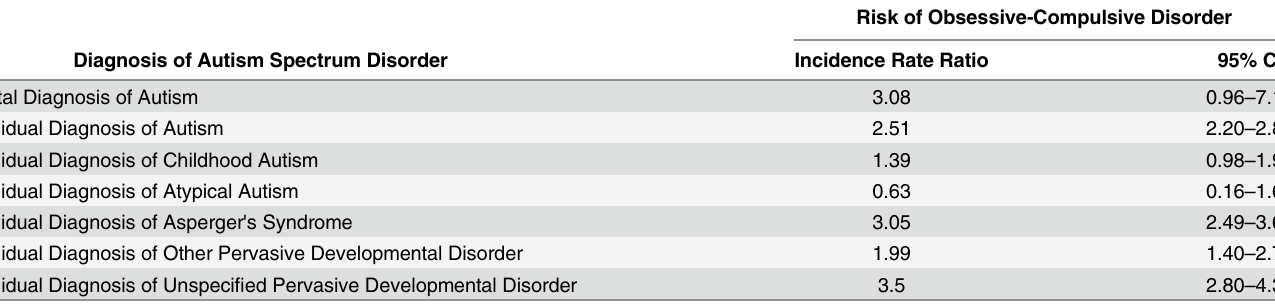
Table 2. Incidence Risk Ratio of Obsessive-Compulsive Disorder in Relation to Individual and Parental Diagnoses of Autism Spectrum Disorders (ASD; 1994 – 2012).